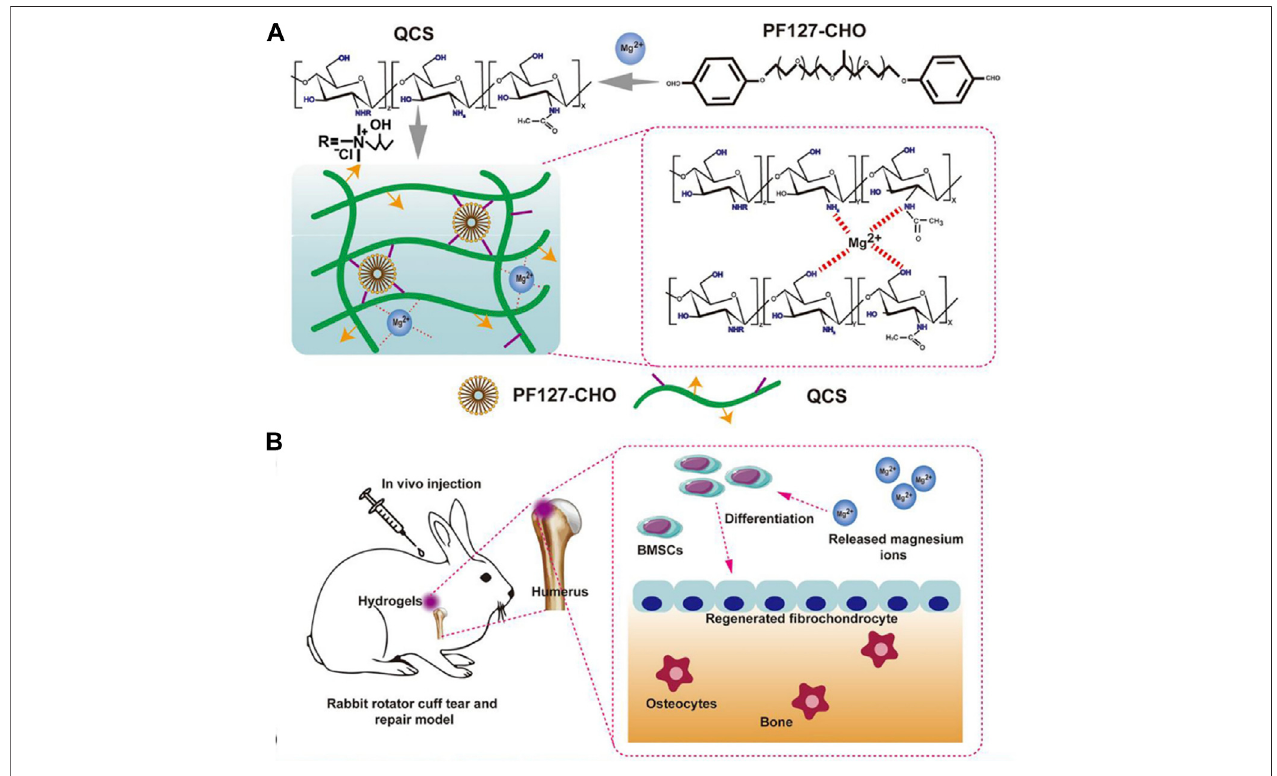
FIGURE 6 | Illustration of 3D printing multiphasic scaffold for tendon-bone interface engineering. (Reprinted from (Cao et al., 2020) with permission from Elsevier).